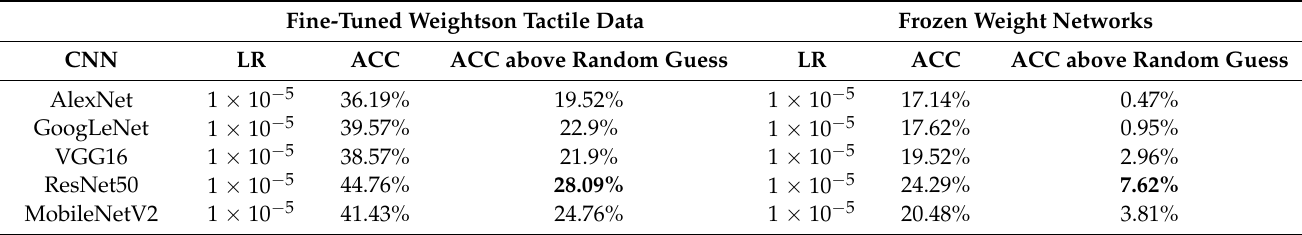
Table 3. Classification results for tactile data collected by 16 by 16 force-sensing resistor (FSR) array. All networks are trained on a minimum batch of size 16 and for 10 epochs.